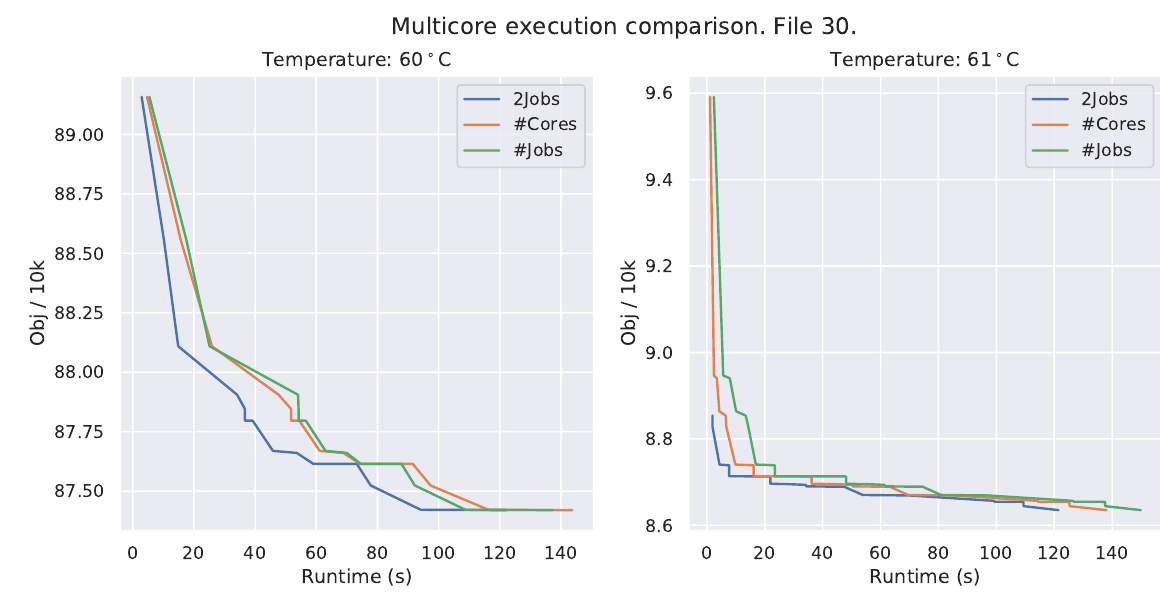
Figure 14. Evolution of the objective function for different multicore approaches.